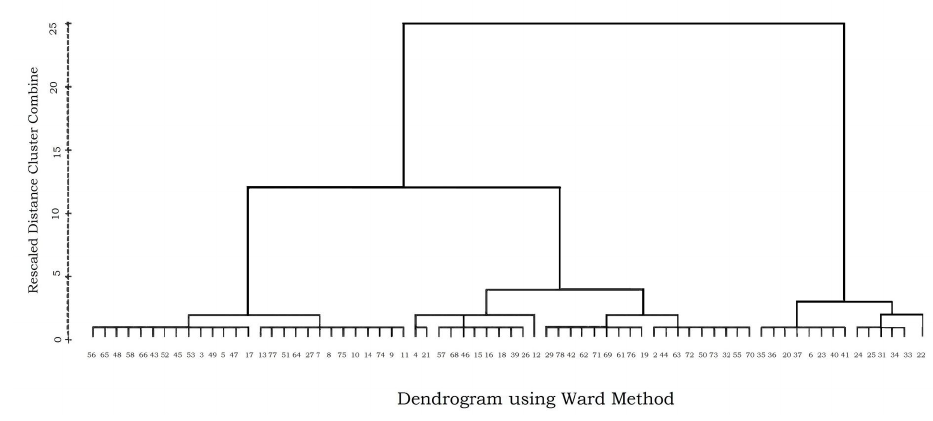
Fig. 5. Hierarchical Cluster Analysis (HCA) of 70 individual sampling stations in Khao Lak sediment. 2